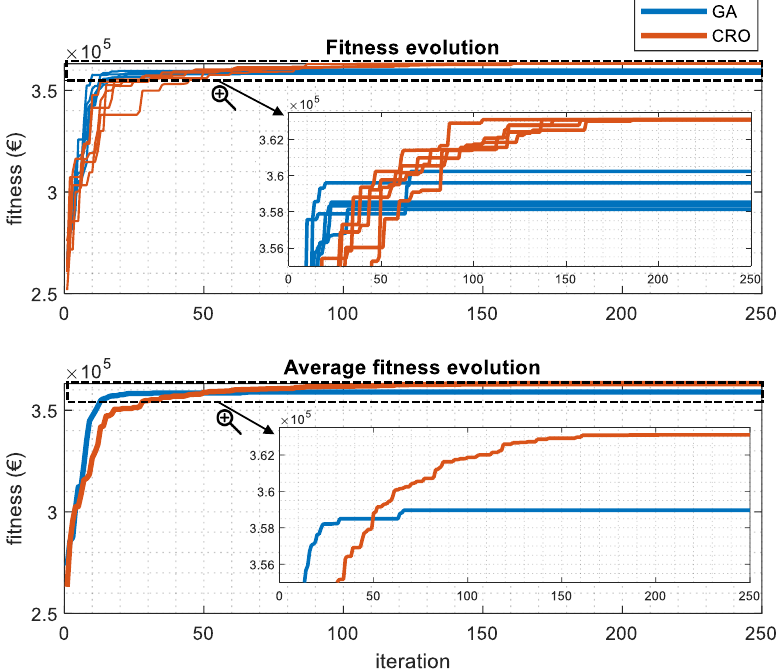
Figure 5. Comparison of the fitness achieved using the GA and the